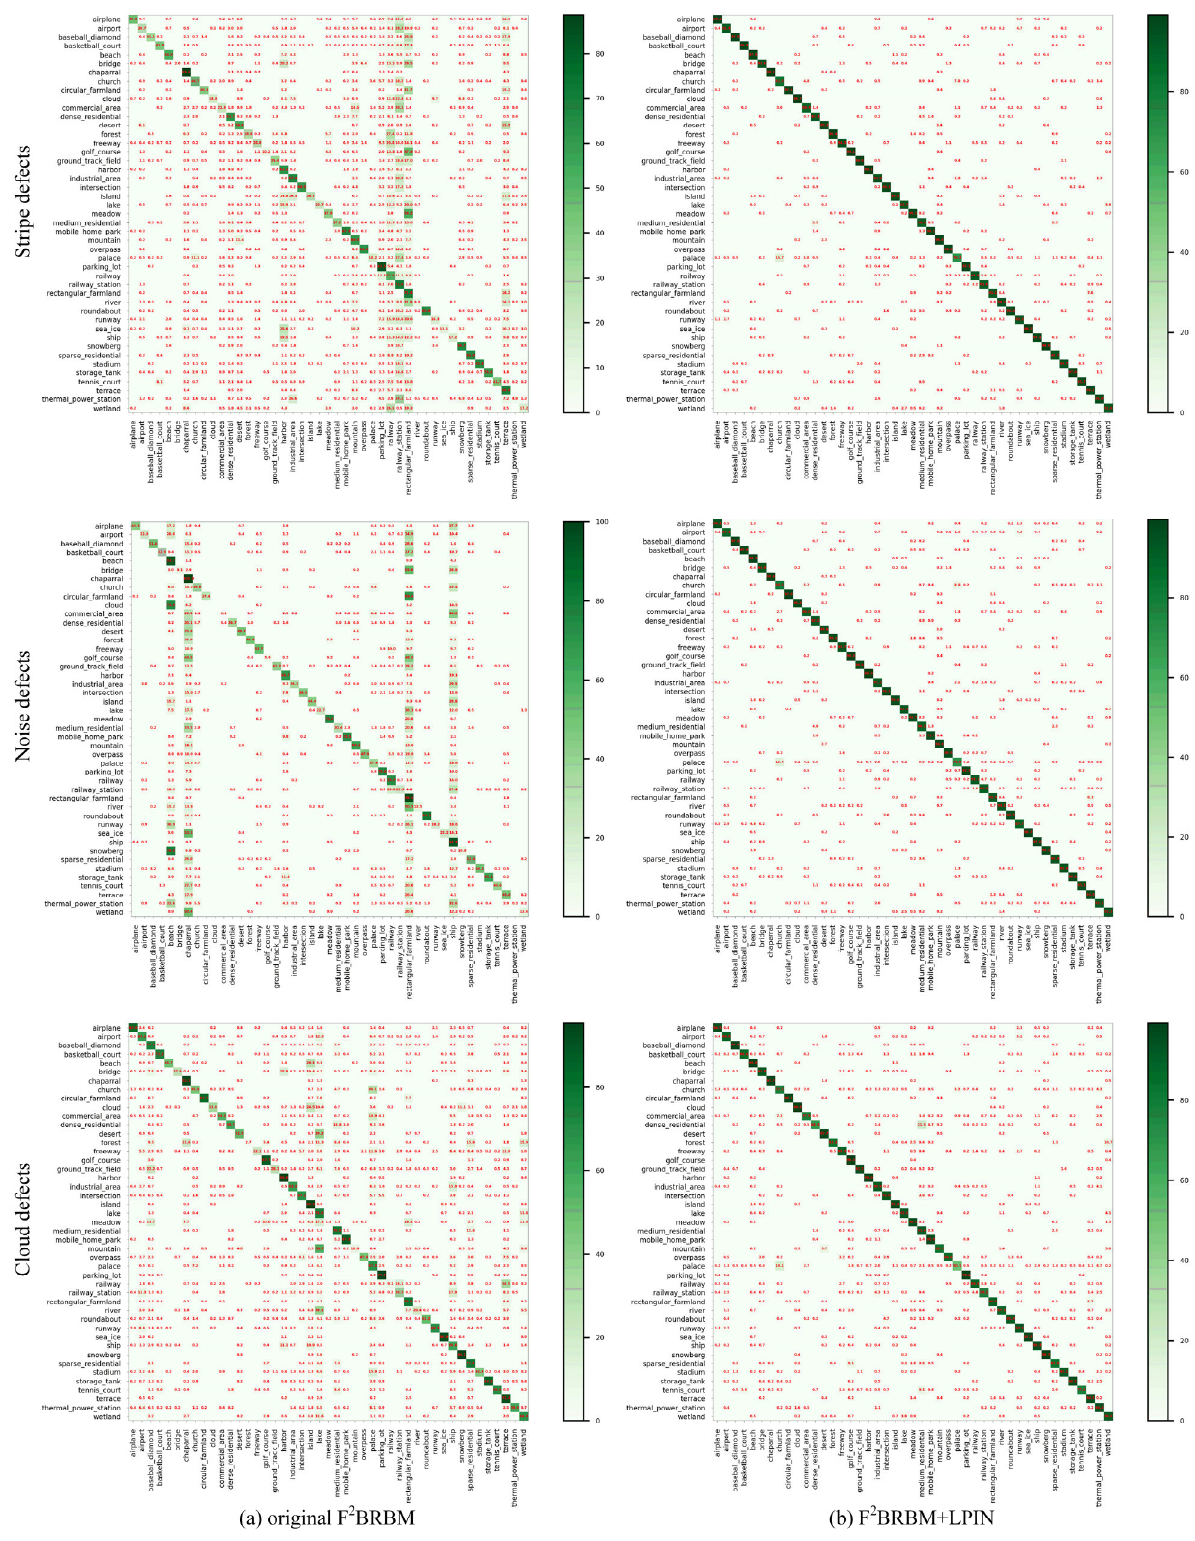
Figure 13. Confusion matrixes of the original F2BRBM ( a ) and F2BRBM + LPIN ( b ) on NWPU-RESISC45 with different defects.